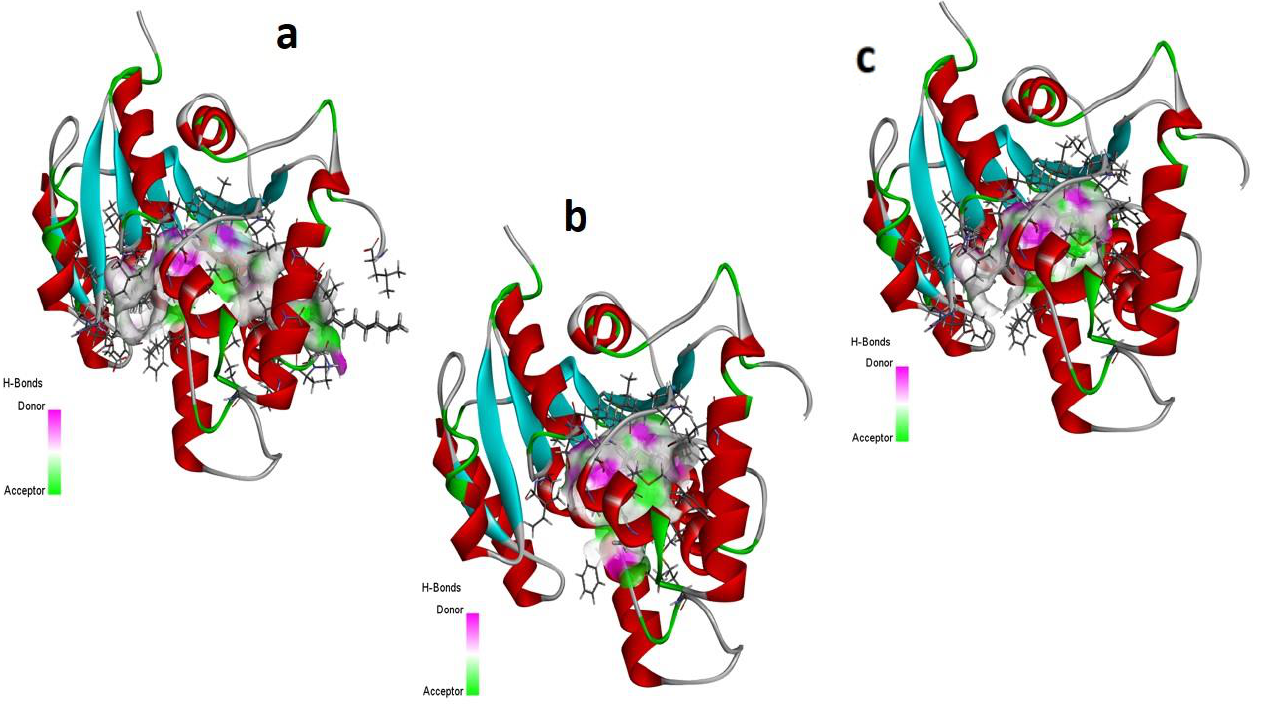
Figure 10. Hydrogen bonding capacity of top three scored docked ligands CID_10440 ( a ), CID_5367460 ( b ), and CID_22371644 ( c ), within the active site of antibacterial protein [PDB ID: 4TZK]. Purple colored area presents the hydrogen bond donor capacity and the green colored area presents the hydrogen bond acceptor capacity.